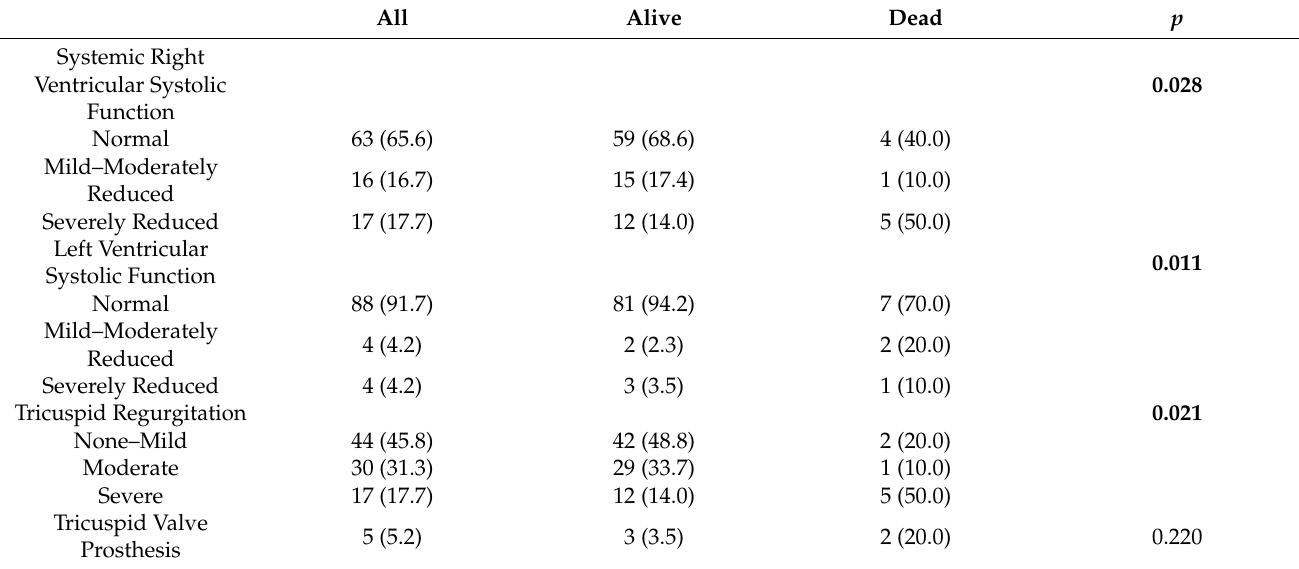
Table 2. Echocardiography at